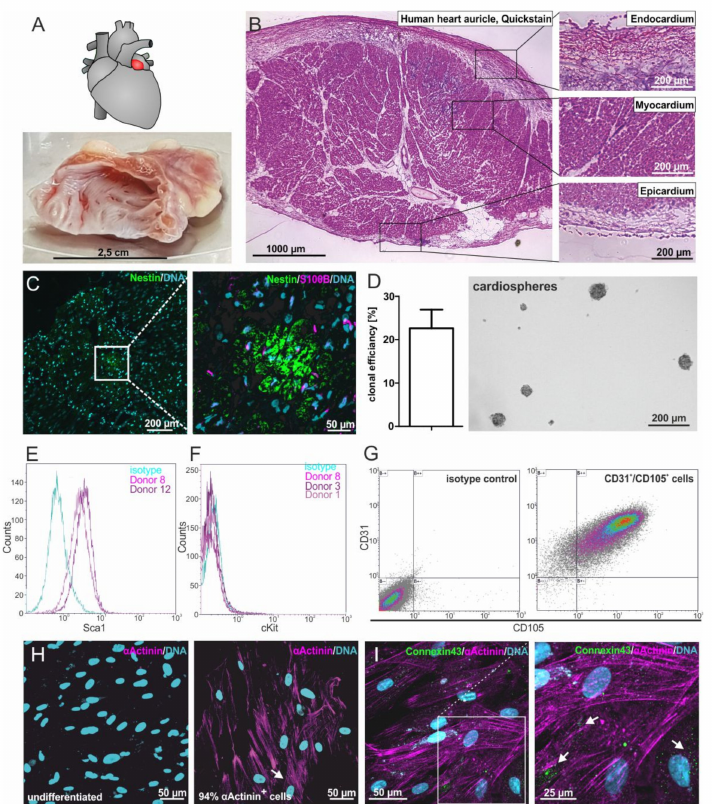
Figure 1. Isolation and characterization of adult human cardiac stem cells (hCSCs). ( A ) Human heart auricles were removed during routine heart surgery. ( B ) Heart auricle tissue consists of the three main layers: endocardium, myocardium and epicardium. ( C ) Nestin + and S100 + cells can be found in the myocardium of the human heart auricle. ( D ) Isolated cells spontaneously form cardiospheres and possess the ability for self-renewal with a clonal e ffi ciency of 22.7%. ( E ) Cultured cells express the cardiac stem cell marker Sca1. ( F ) Cultured cells do not express the stem cell marker cKit. ( G ) Double staining shows that cultured cells coexpress the cardiac stem cell markers CD31 and CD105. ( H ) After cardiac di ff erentiation with biochemical cues, 94% of cells express the cardiomyocyte protein α -actinin. ( I ) After di ff erentiation with biochemical cues, the gap junction protein Connexin43 is expressed at the surface of α -actinin + cells, indicated by